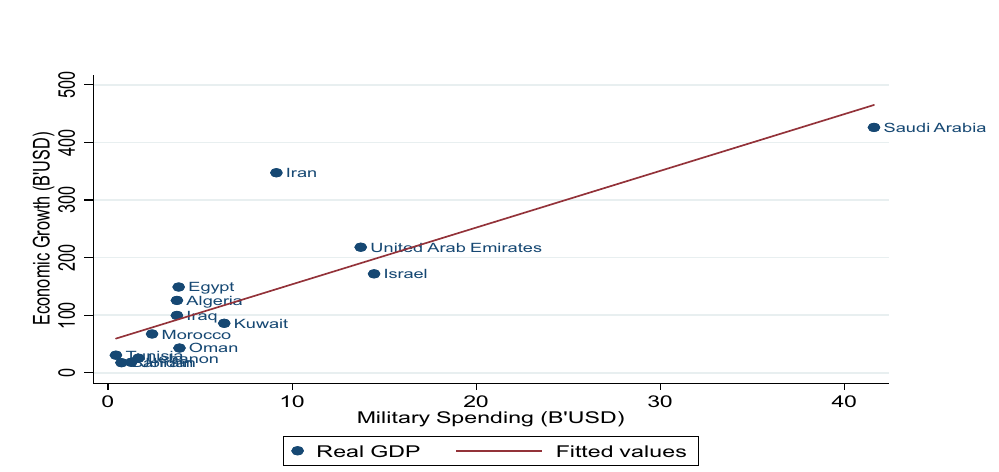
Fig. 5 Real GDP and military spending in selected MENA